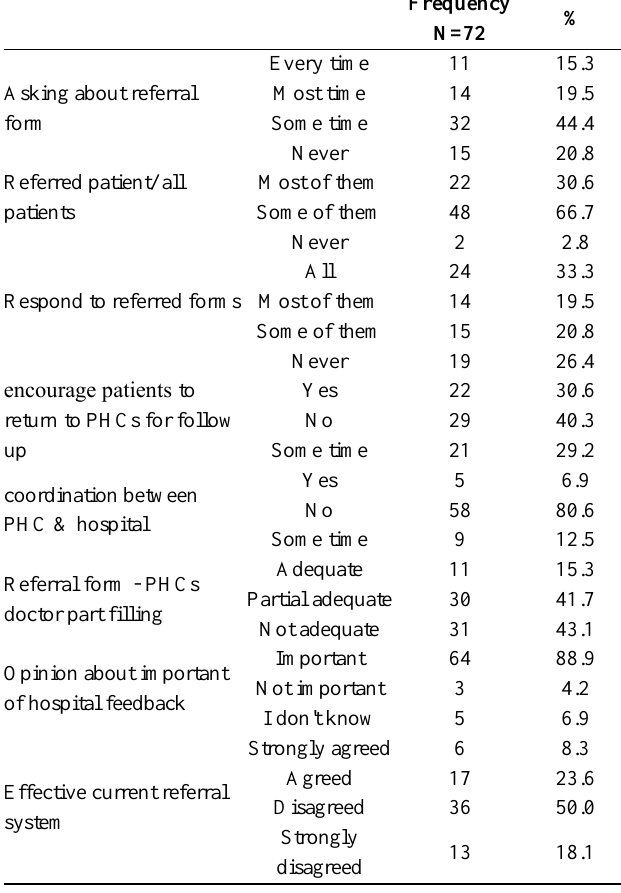
Table 2 : Distribution of studied doctors according to the